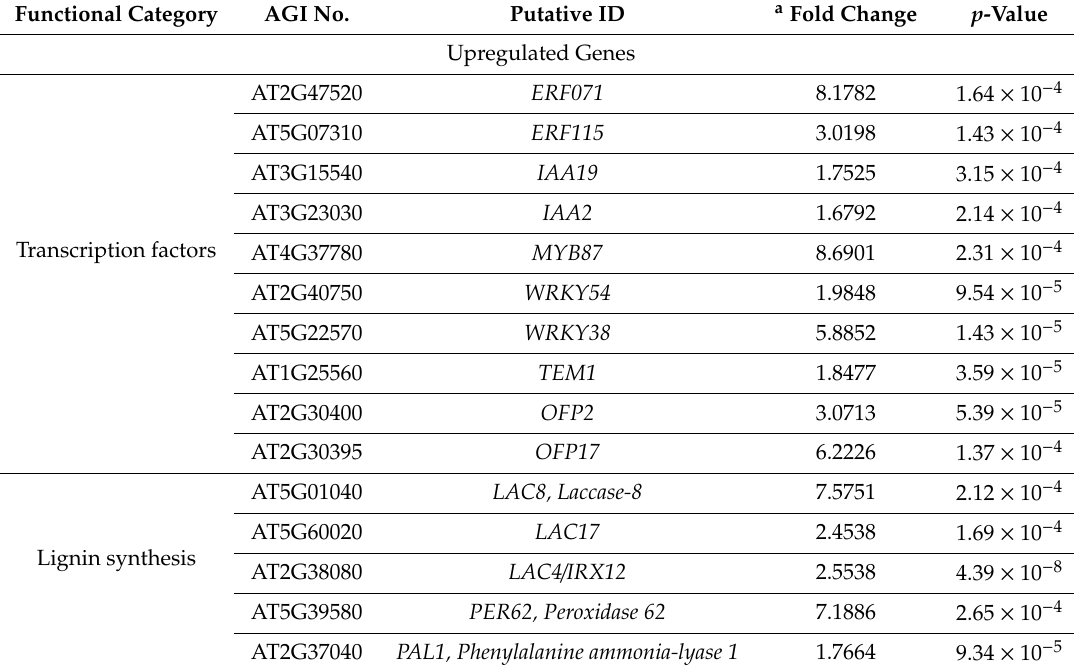
Table 1. Expression patterns of selected vascular tissue related